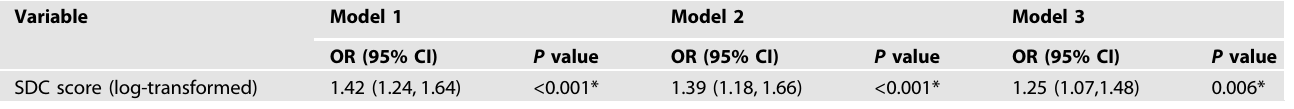
Model 1: crude model; Model 2: adjusted for neuroimaging covariates including timing of imaging since stroke onset, lesion localization and lesion volume; Model 3: additionally adjusted for all sociodemographic, clinical, and psychological factors. SDC structural disconnection, OR odds ratio, CI con fi dence interval. * P <0.05.